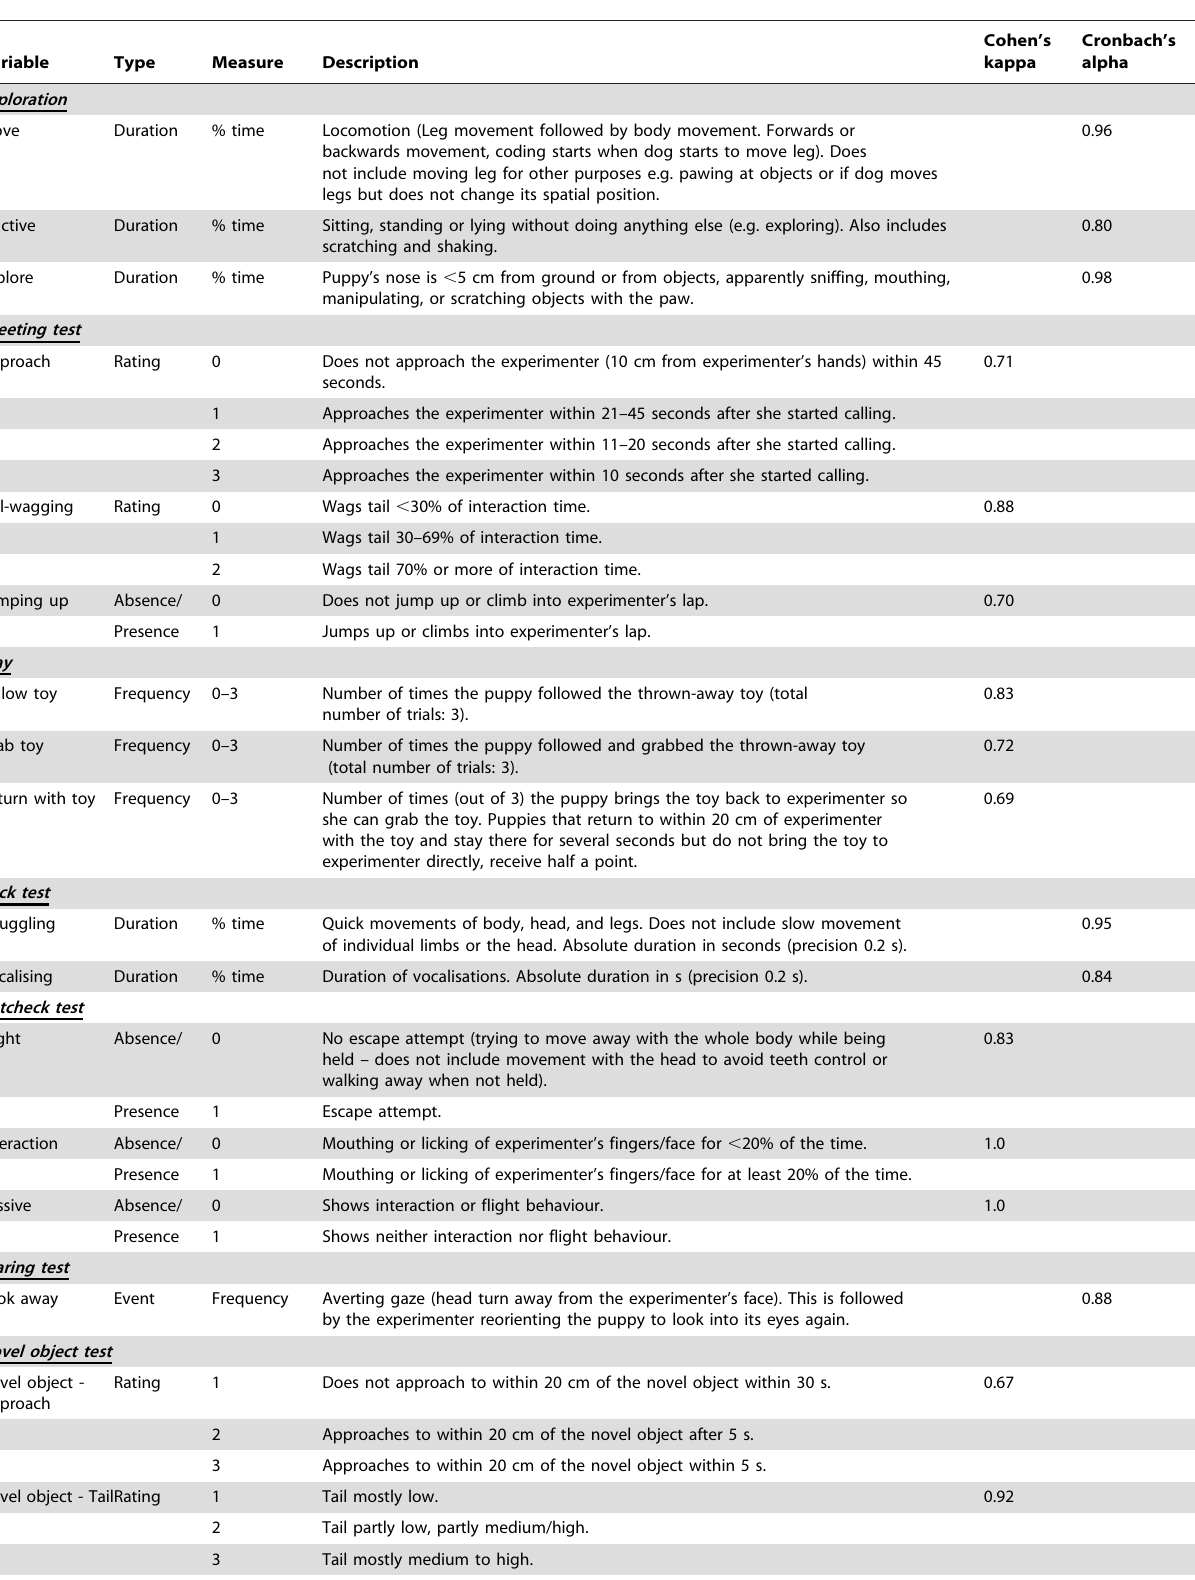
Table 4. Description of behavioural measurements used in the analysis of the puppy test.